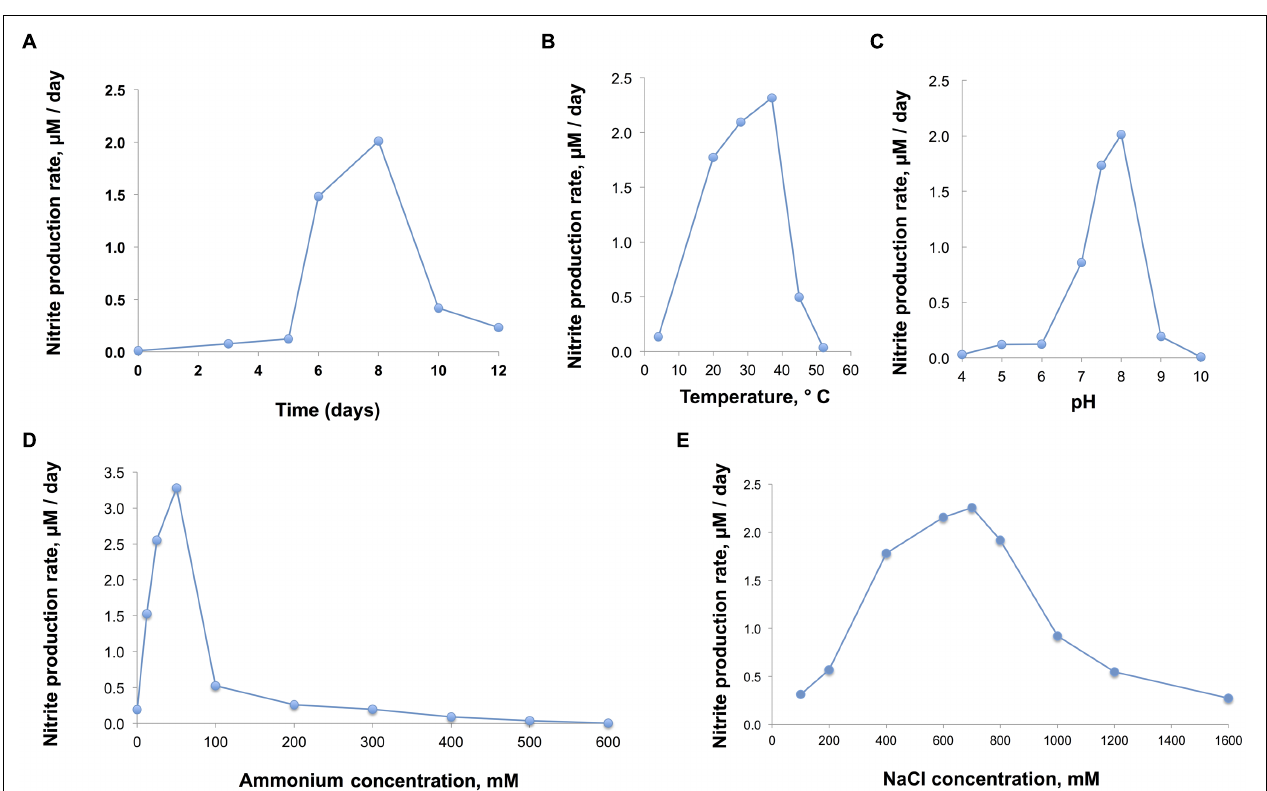
FIGURE 4 | (A) Growth of D1FHS (assessed by maximum nitrite production rate) in AMS-H standard medium with 700 mM NaCl and 12.5 mM (NH 4 ) 2 SO 4 at pH 8, grown at 28 ◦ C in the dark. (B,C) Physiological tests: growth of D1FHS in AMS-H in the dark (assessed by maximum nitrite production rate) was characterized as a function of (B) temperature and (C) pH conditions. Data points are mean values calculated from three biological replicates. (D) Physiological tests: growth of D1FHS in AMS-H in the dark (assessed by maximum nitrite production rate) was characterized as a function of ammonium concentration. Data points are mean values calculated from three biological replicates. (E) Physiological tests: growth of D1FHS in AMS-H in the dark (assessed by maximum nitrite production rate) was characterized as a function of NaCl concentration. Data points are mean values calculated from three biological